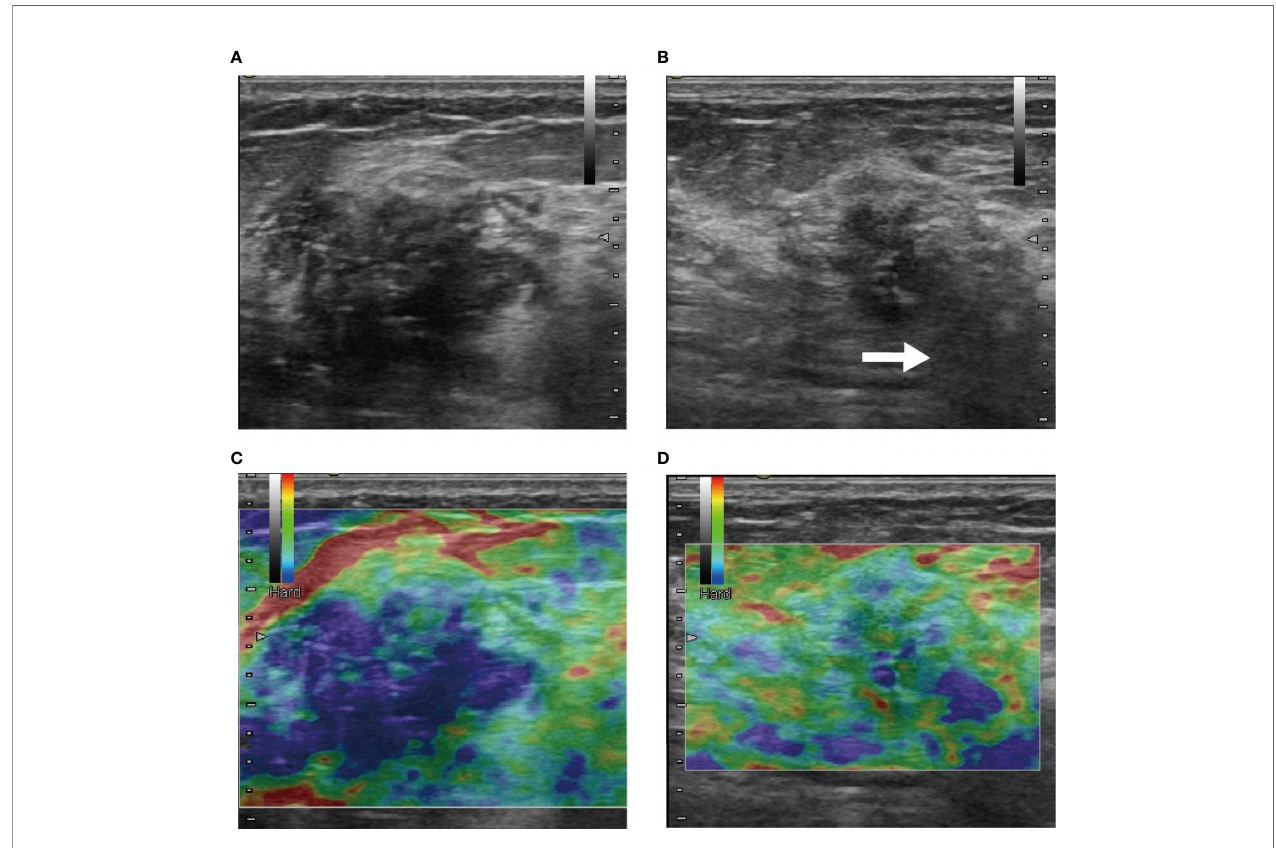
FIGURE 5 | These were B-mode (A, B) and elasticity ultrasound (C, D) images of a patient who was treated with NAC and who eventually achieved pCR. (A, C) The initial images before NAC. (B, D) Images after two-cycle response. In B-mode images (A, B) , size shrinkage was obvious, and the posterior acoustic changed to shadowing (white arrow) after the two-cycle response was visible. From the elasticity ultrasound images (C, D) , we observed that the range of rendering blue was reduced, which mean that the elasticity score was